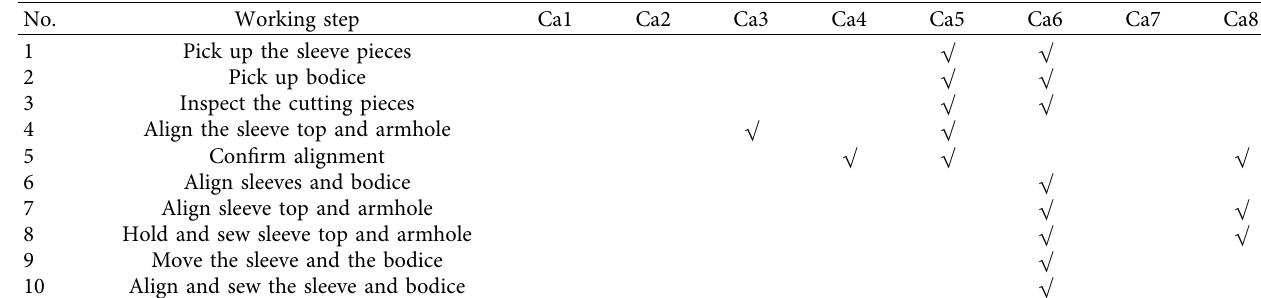
Table 9: Cognitive activities (Ca1-Ca8) of setting in